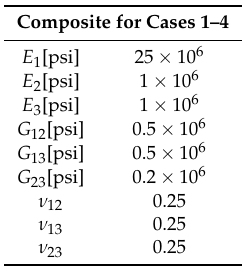
Table 1. Material data for the employed composite layers.